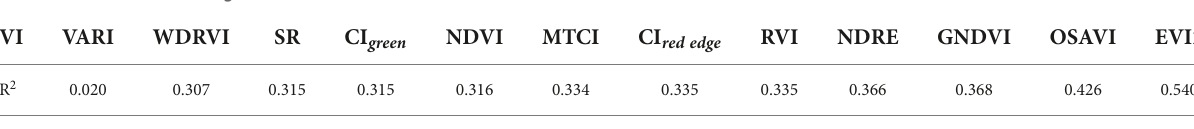
TABLE 4 R 2 of the linear regression of rice LAI with VIs.